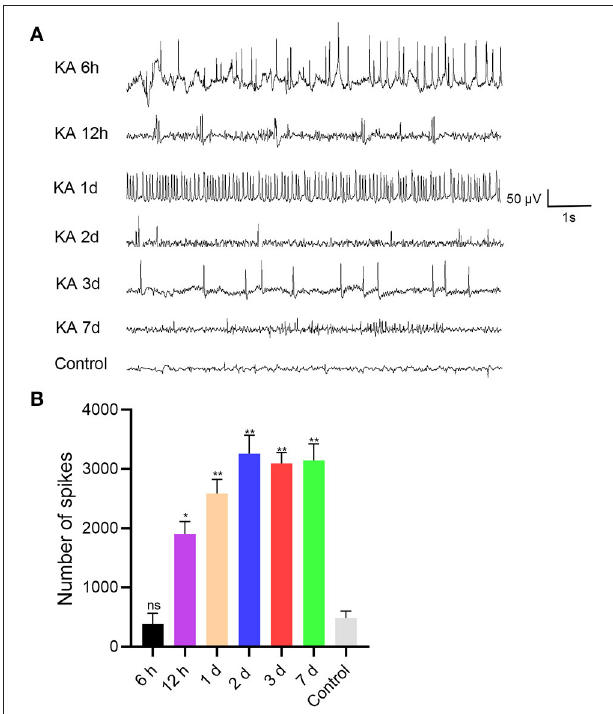
FIGURE 2 | EEG was recorded after intracranial injection of KA or saline in C57BL/6J mice ( n = 6 per group). (A) EEG analysis was performed on the mice, and representative images were displayed. (B) The number of seizure spikes in EEG. Statistically significant differences were determined using the unpaired t -test. Data are presented as means ± SD ; * p < 0.05; ** p < 0.01; ns, not significant. EEG, electroencephalography; KA, kainic acid; ns, not